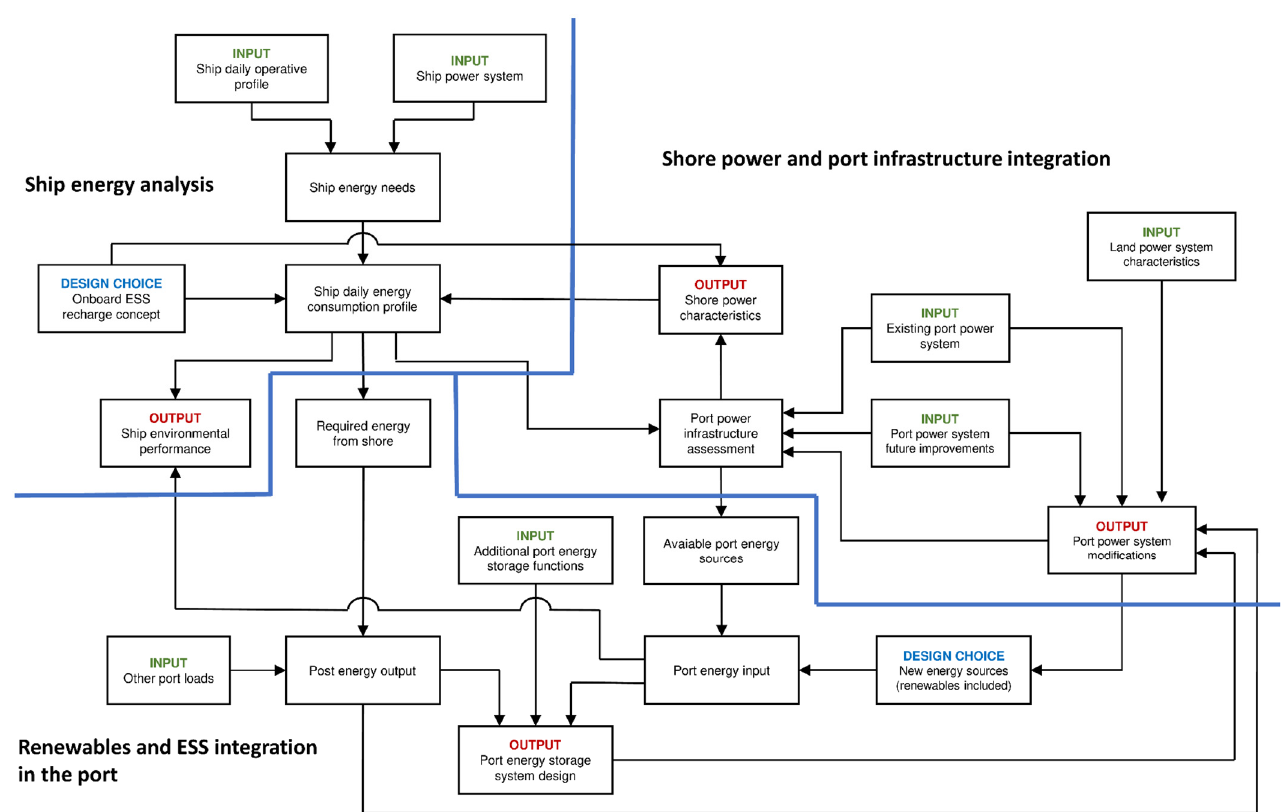
Figure 1. Proposed methodology for the integration of environment-friendly ships, shore connection apparatus, energy storage system, and port electrical infrastructure, including the subdivision in sub-processes (blue lines), whose denomination (bold black text) refers to the title of the paper sections in which their application to the case study is described.